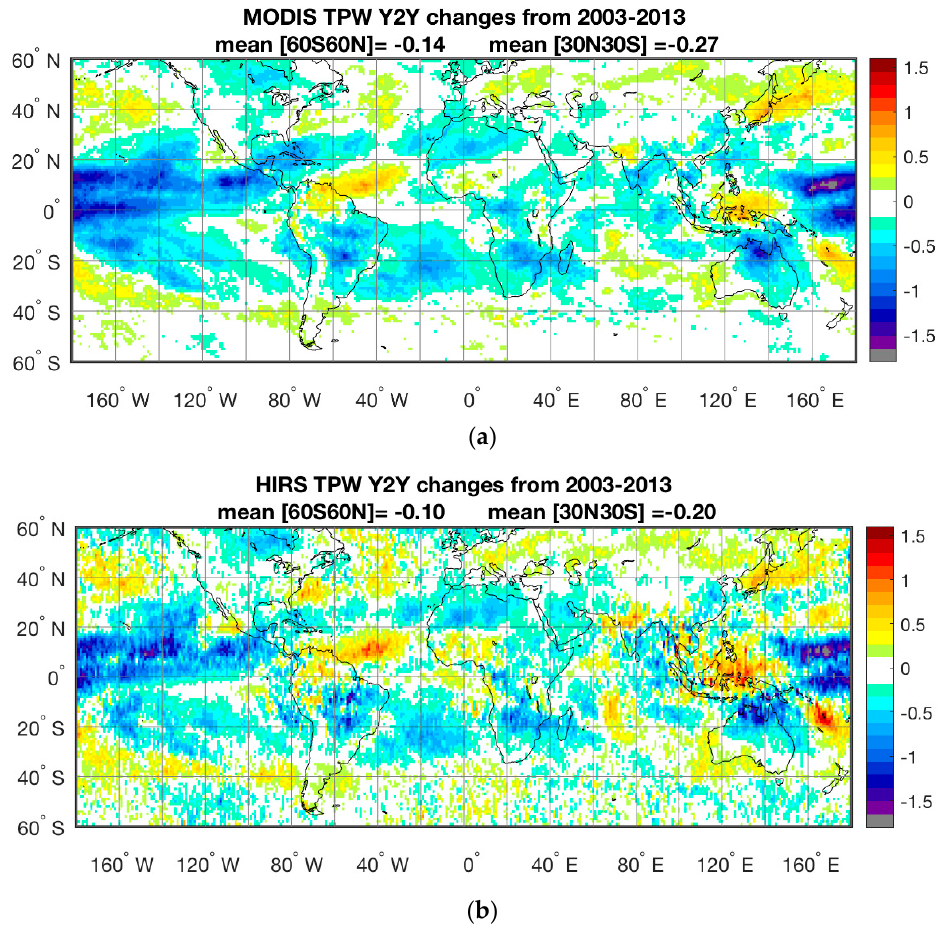
Figure 9. ( a ) MODIS Aqua mean year to year change in TPW for 2003–2013. The same months are used as in the HIRS data below. Spatial resolution is one degree. ( b ) HIRS mean year to year change TPW for 2003–2013. Spatial resolution is 1 degree. Data from the HIRS sensors on NOAA-16, -18, and -19 are included. Same sensor detection of TPW differences for the same month from one year to the next are computed separately for all twelve months and then aggregated over the years 2003–2013; averages are taken over all months to infer mean changes. Overall mean for Tropics (denoted by [30N30S]) and for the 60 ◦ S and 60 ◦ N latitude band (denoted by [60S60N]) are in the